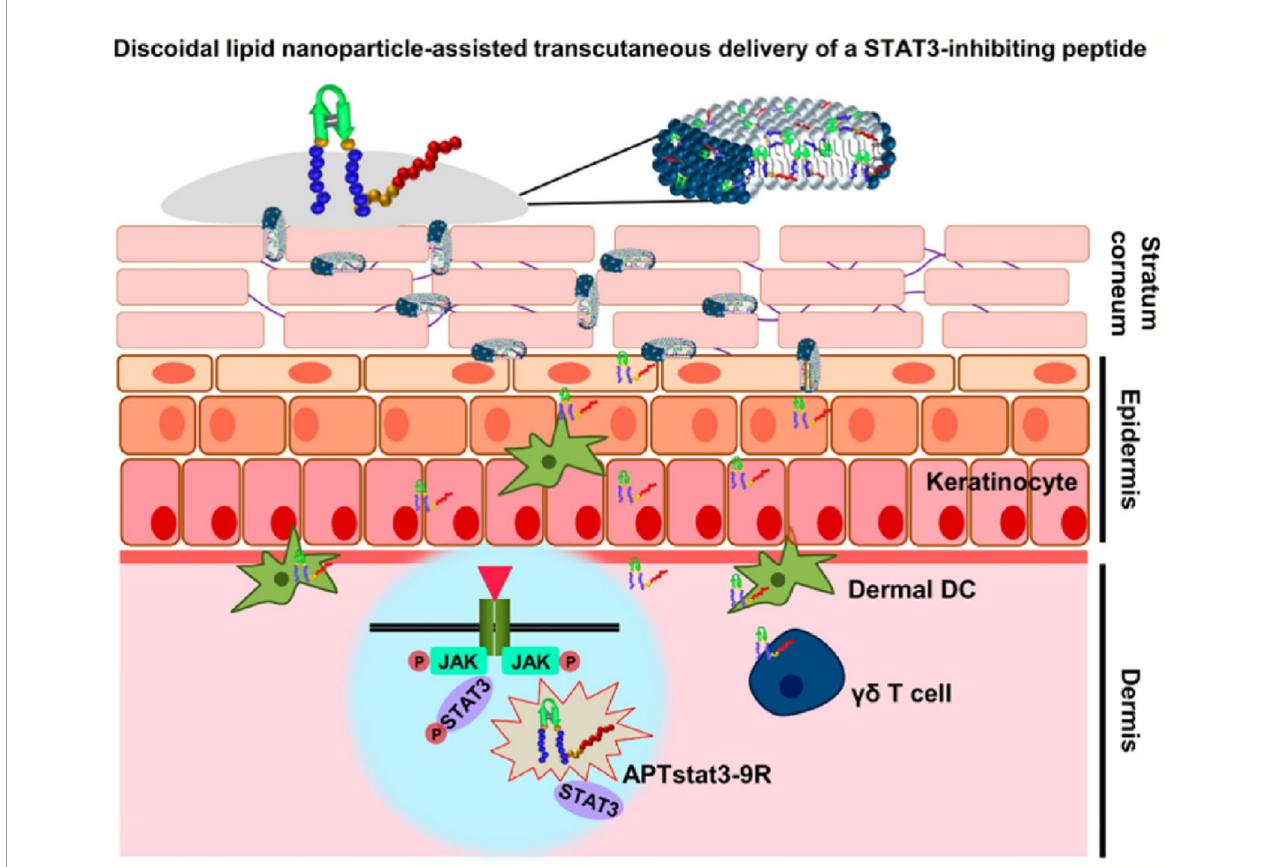
FIGURE 4 | DLNPs deliver APTstat3 for Psoriasis treatment via transcutaneous administration (Kim et al., 2018) (with reproduction